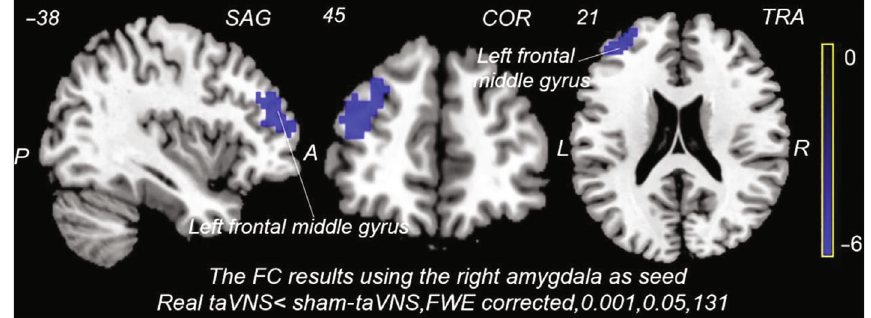
Figure 6: The functional connectivity (FC) of the right amygdala in MwoA during continuous stimulation (taVNS vs. staVNS). SAG: sagittal; COR: coronal; TRA: transverse; FWE: familywise error correction. Compared with staVNS, the FC of the right amygdala and left frontal middle gyrus signi fi cantly decreased during taVNS (voxel-level p < 0 : 001 and cluster-level p < 0 : 05 ). FWE 0.6 p < 0.001 p = 0.685